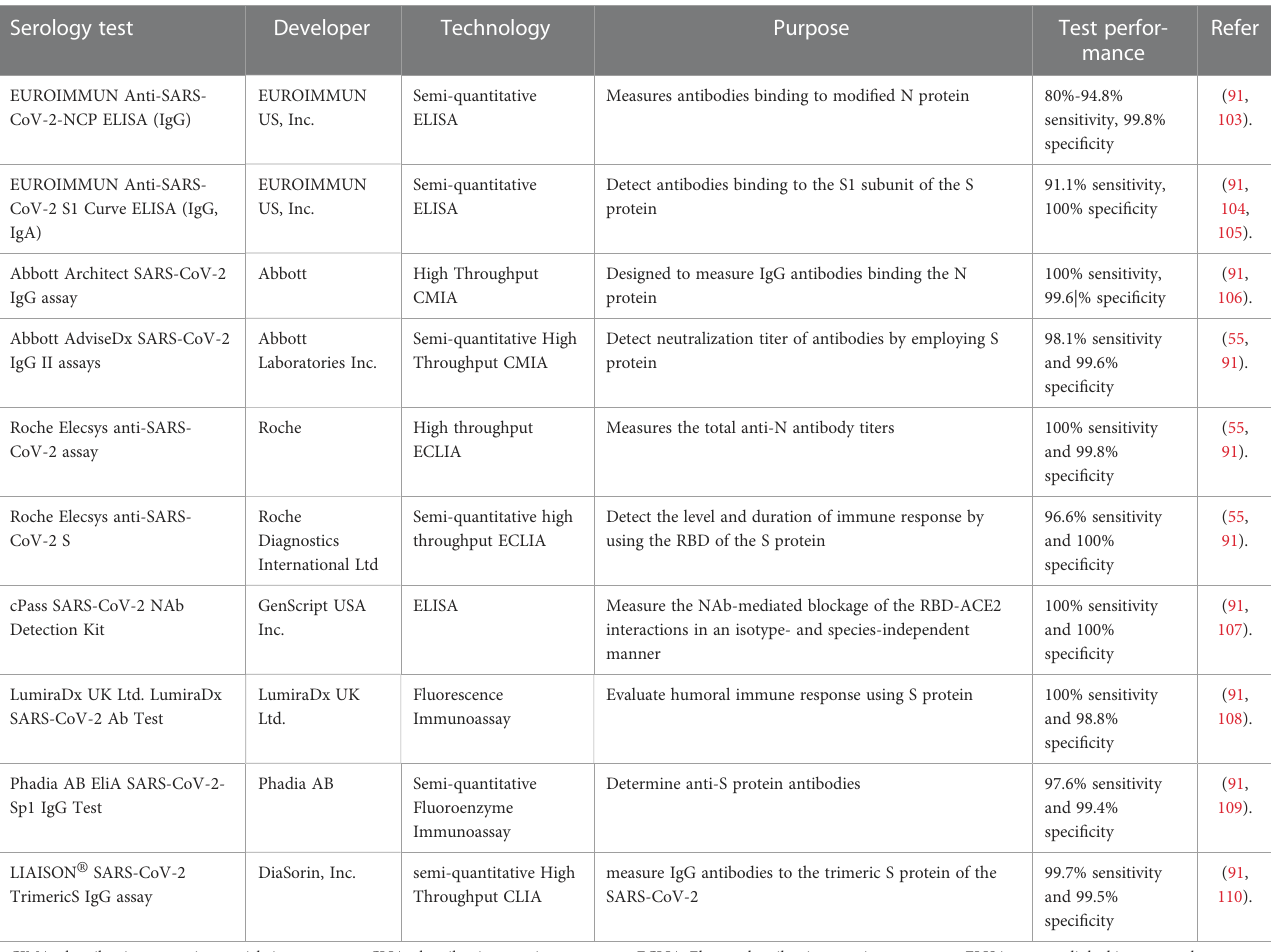
TABLE 2 Some EUA authorized serological assays measuring humoral immune response or antibody